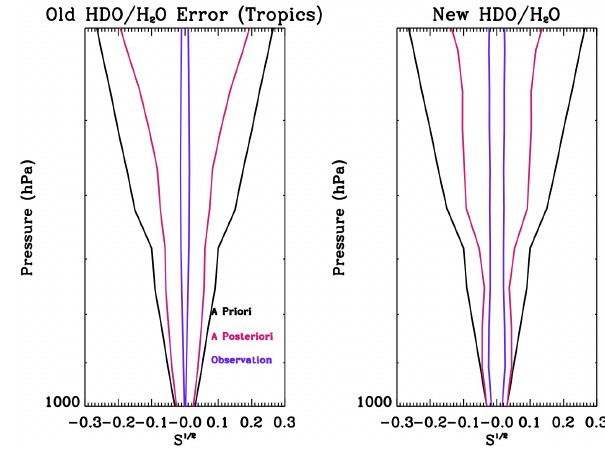
Figure 4b: Same as in Figure 2b but for the HDO/ H O ratio. The units are Fig. 4b. Same as in Fig. 2b but for the HDO/H 2 O ratio. The 2 approximately the fractional uncertainty as the TES trace gas retrievals estimates the log of the concentrations.